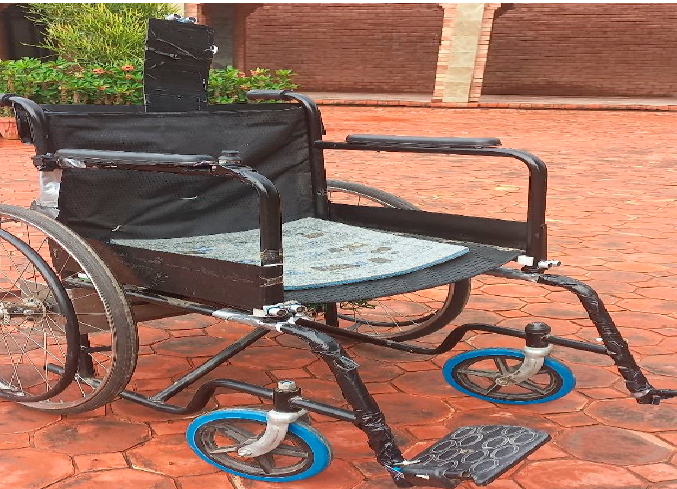
Figure 9. Manual Wheelchair is converted to multi-mode electric wheelchair by installing designed conversion